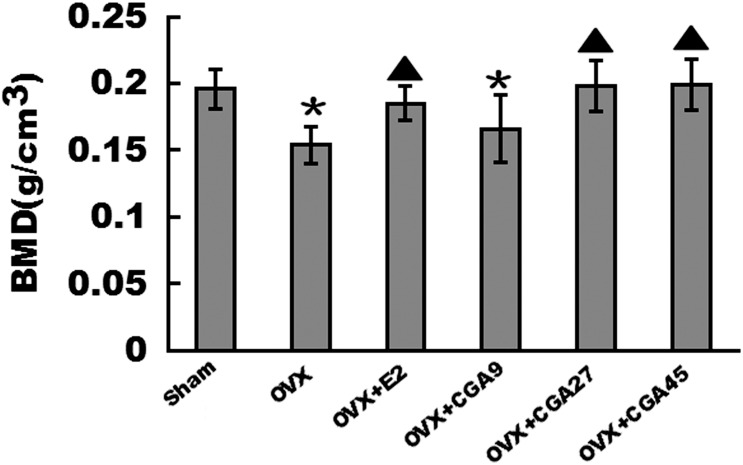
Effect of E2 and CGA on BMD in OVX rats.Each column represents the mean ± SD of 10 rats. *p < 0.01 vs. sham group. ▲ increase vs. OVX group (p < 0.01).